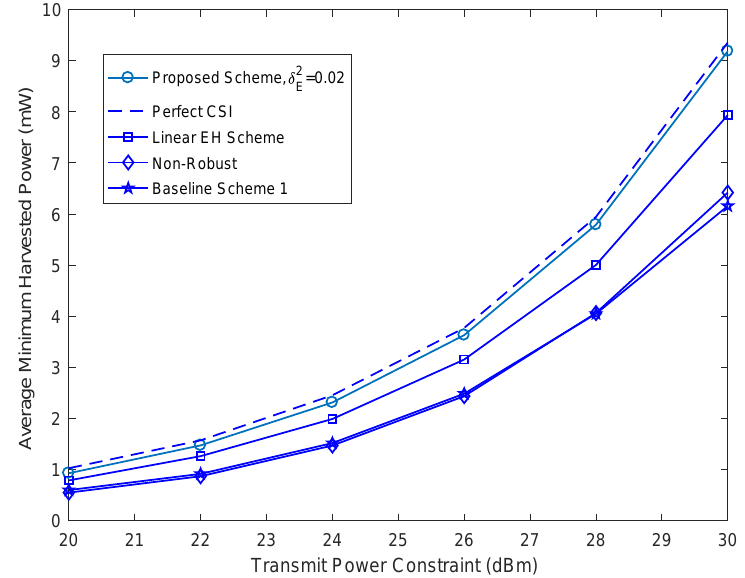
Figure 2. Average minimum harvested power per energy vehicular receiver versus total transmit power, P